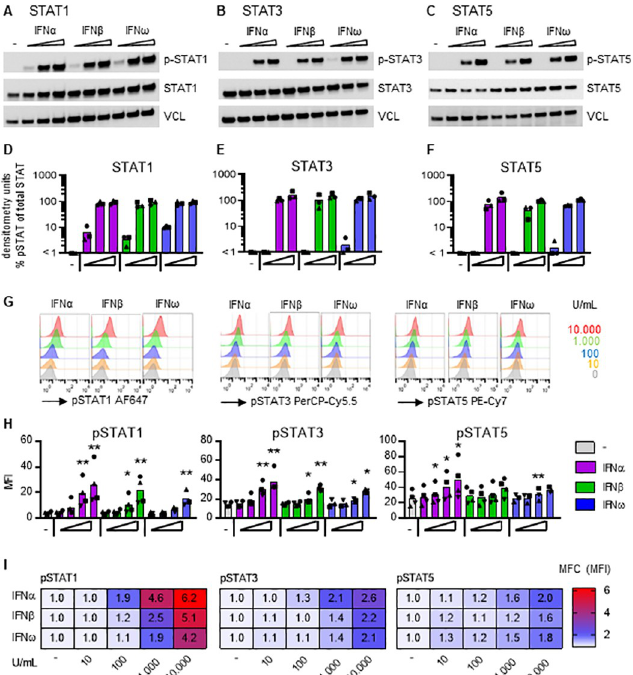
Fig 5. IFN-induced phosphorylation of STAT. Total CD4 + T cells, isolated from blood donors not living with HIV, were treated for 10 minutes with increasing (0; 100; 1,000; 10,000 U/mL) concentrations of IFN α , IFN β or IFN ω , and phosphorylation of A: STAT1, B: STAT3 and C: STAT5 was detected by Western Blot analysis of cell lysates. Figure shows a representative donor from a total of 3 individual donors that were obtained during 2 independently performed experiments. P-STAT = phosphorylated STAT, STAT = total (unphosphorylated) STAT, VCL = vinculin that is used as loading control. Graphs depict the densitometry analysis of the immunoblot band intensity and show relative STAT phosphorylation as compared to total STAT; D: STAT1, E: STAT3, F: STAT5. G-I: Phosphorylation of (p)STAT1, STAT3 and STAT5 was measured in total CD4 + T cells, isolated from HIV-uninfected blood donors, by flow cytometry after 15 minute treatment with increasing (0–10,000 U/mL) concentrations of IFN α , IFN β or IFN ω , as indicated. G: Representative histograms of flow cytometry analysis showing the IFN-induced change in mean fluorescent intensity (MFI) of the different STAT proteins. H: Graphs showing the IFN-induced changes in pSTAT MFI, bars represent mean values and each symbol represents an individual donor (n = 3–4). I: Heat map shows the mean fold change (MFC) from 3–4 donors of the mean fluorescent intensity (MFI) of the treated condition (shown in H) relative to the untreated condition. � p < 0.05, ��� p < 0.001, as determined with paired student T test. MFI statistics were done on log-transformed data. Fold change calculations used non-transformed raw